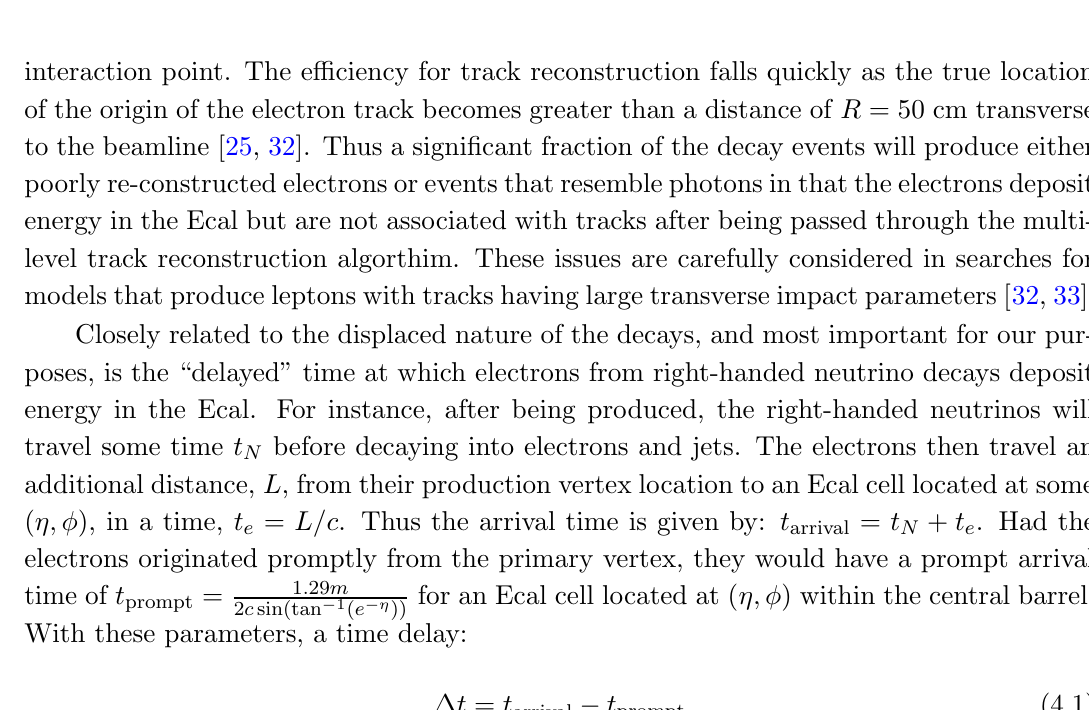
Figure 3 . p distribution of the leading electron from right-handed neutrino decays ( M T 50 GeV). In this case, the default Delphes CMS card e(cid:14)ciencies have been applied. These include, for instance, zero percent e(cid:14)ciency for electron p